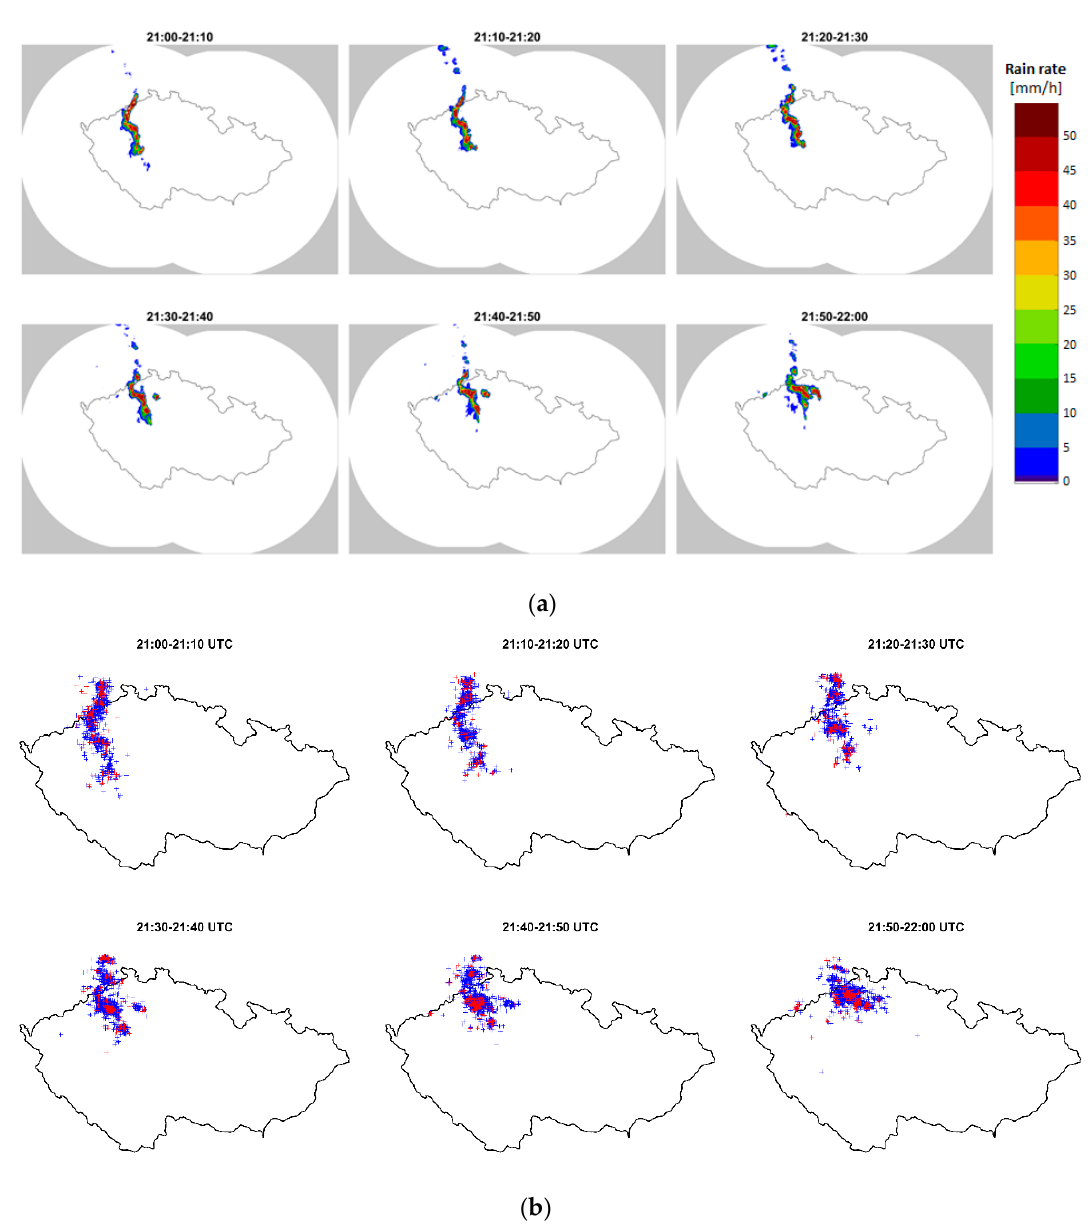
Figure 2. Temporal evolution with a 10-min time step of ( a ) rain rates derived from C-band weather radar data (radar circle domains having a radius of 250 km) and ( b ) lightning discharges between 21 and 22 h UTC as registered by EUCLID network on 10 June 2019. Note that in ( b ), blue symbols represent Cloud-to-Cloud (CC) flashes while red symbols display Cloud-to-Ground (CG) flashes. The Milešovka position is shown in Figure 1.